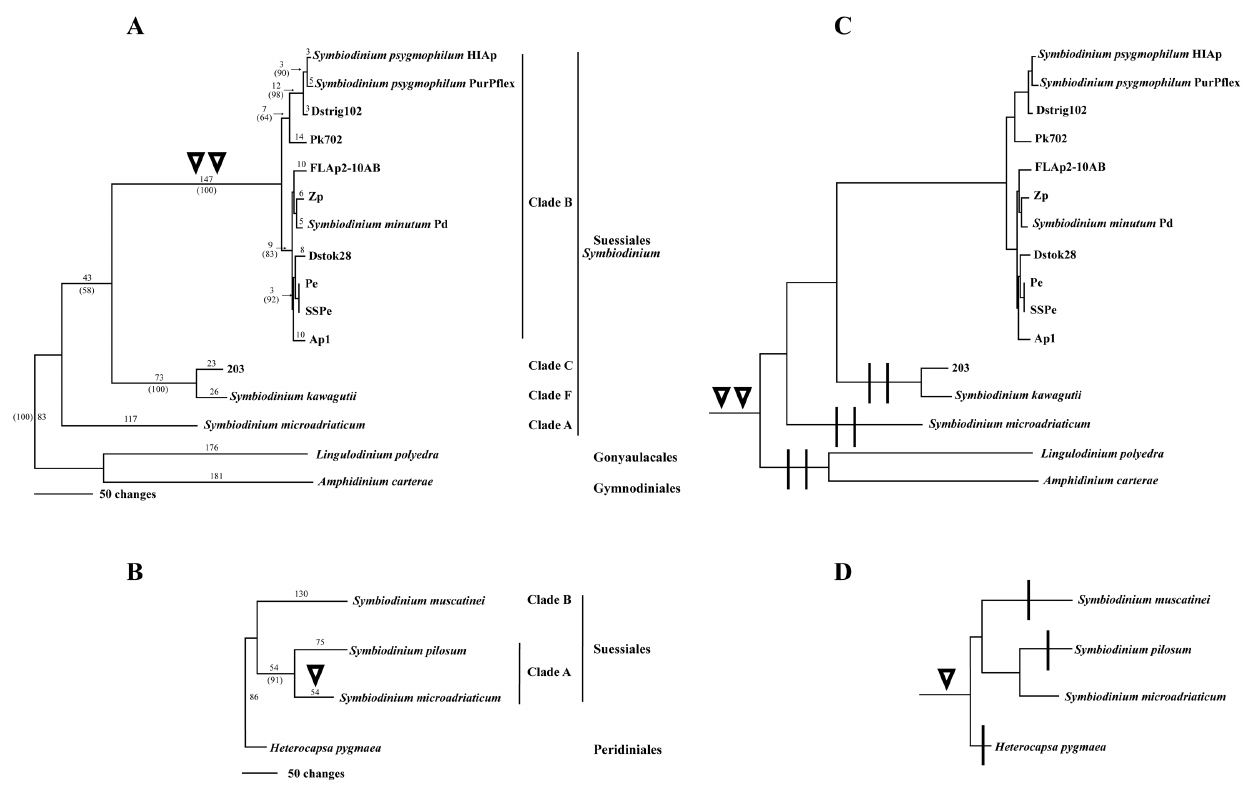
Figure 4. Phylogenies of long and short sPCP coding sequences (excluding introns) from four dinoflagellate orders. (A) Most parsimonious tree for long sPCP CDS data from the Suessiales, Gonyaulacales and Gynnodiniales. (B) Most parsimonious tree for short sPCP CDS from the Suessiales and Peridiniales. Branch lengths are shown above the branches. Support values . 50% based on + 1000 bootstrap trees are shown in parentheses below branches. Double inverted triangles=the long sPCP branch leading to Symbiodinium clade B sequences, each of which contained two introns. Single inverted triangle=the short sPCP branch for the S. microadriaticum sequence that had a single intron. (C) Long sPCP tree redrawn to indicate possibility of ancient introns present in the most recent common ancestor of Suessiales, Gonyaulacales and Gynnodiniales. Vertical bar = loss of an intron on an ascending branch required to explain the data. (D) Short sPCP tree redrawn to indicate possibility of an ancient intron present in the most recent common ancestor of Suessiales and Peridinales. Required losses on ascending branches are indicated as before.